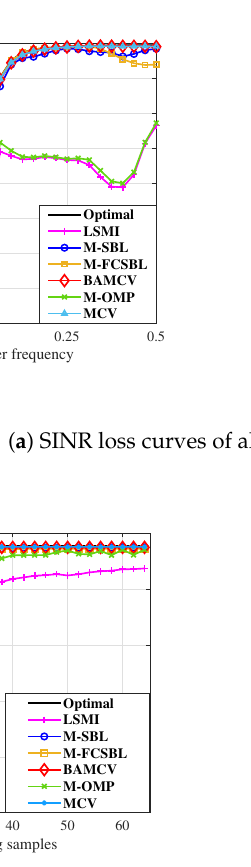
Figure 9. SINR loss versus the number of training samples.